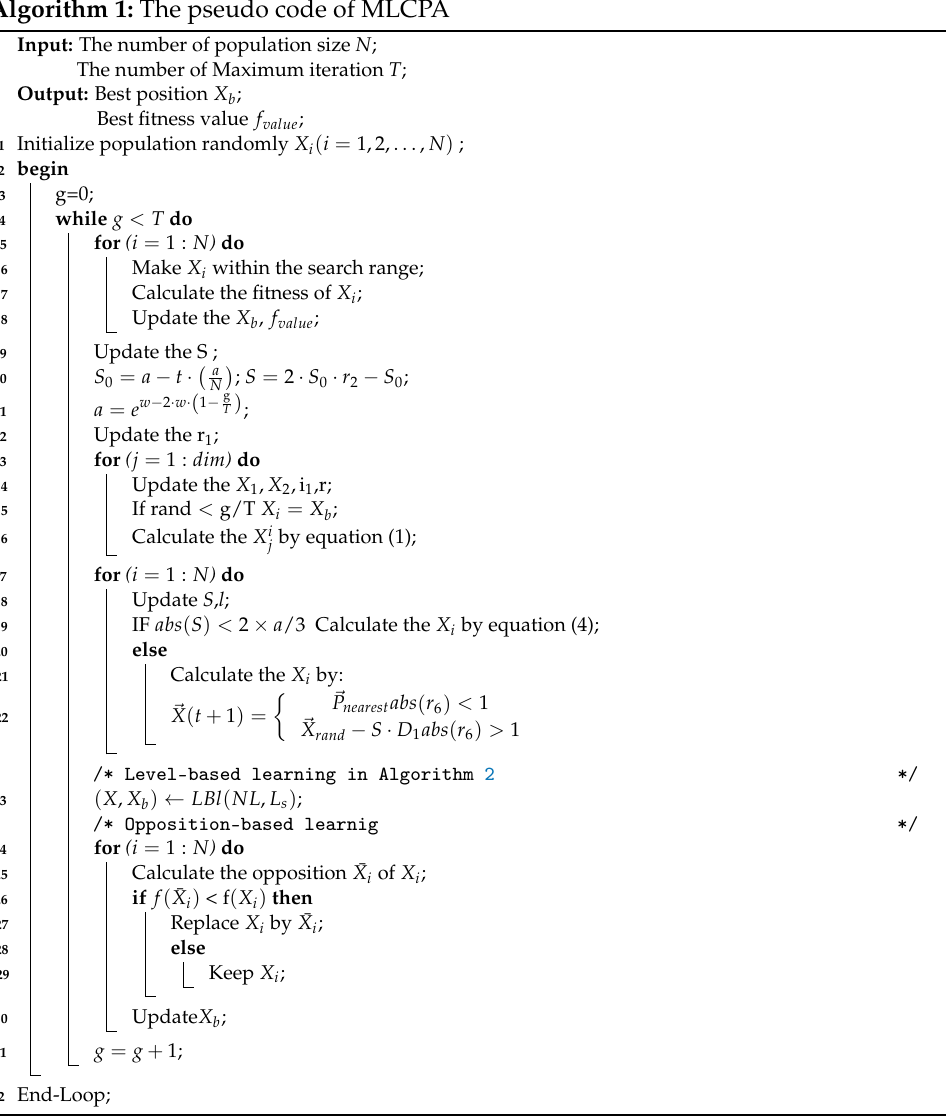
Algorithm 1: The pseudo code of